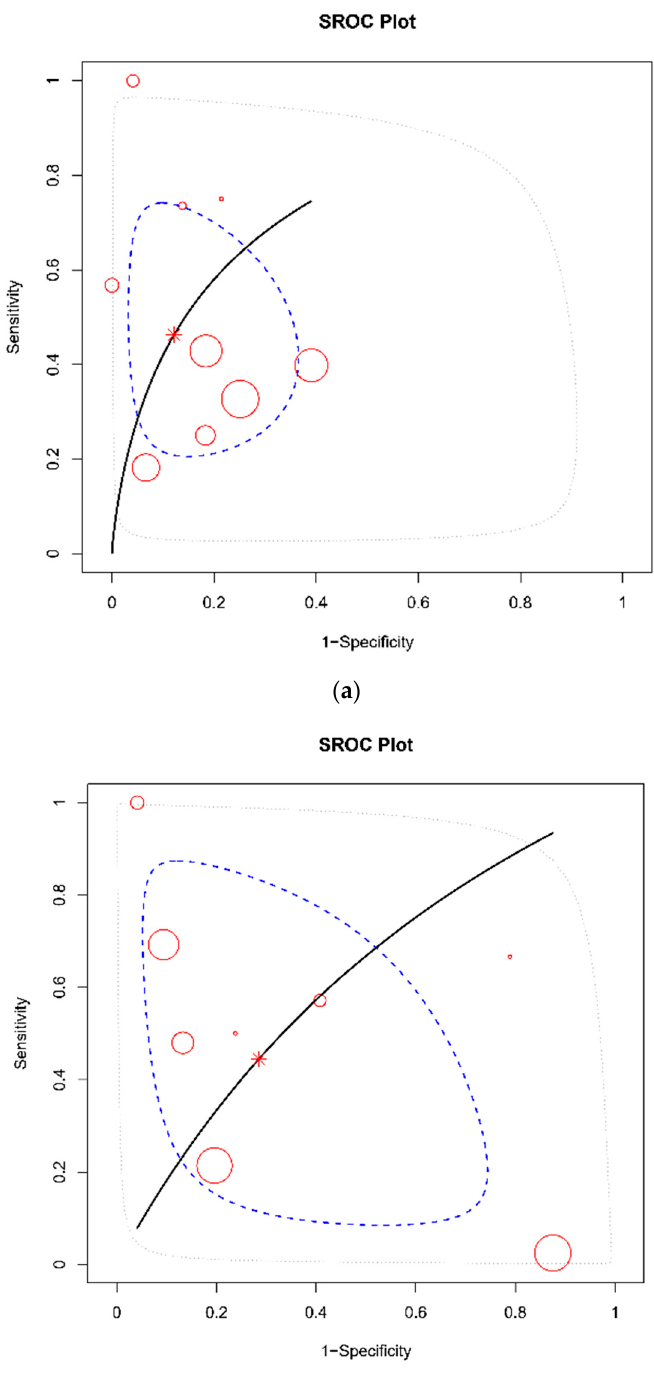
Figure 5. SROC plot for shock development ( a ) and mortality ( b ). Each bubble represents one study and indicates its observed sensitivity and specificity. The size of the bubble is proportional to the number of individuals in the study. The solid black line is the SROC line. The star point represents the summary estimate. The dashed blue line is the 95% credible region and the dashed gray is the 95% prediction region.